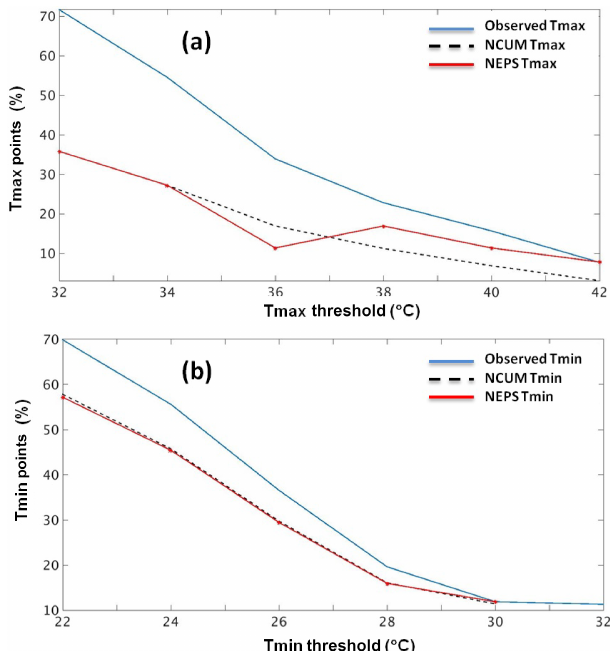
Figure 1. Frequency distribution of observed and forecast (NCUM and NEPS) (a) T max ( ◦ C) and (b) T min ( ◦ C) over India during March to May 2016 (NCUM stands for NCMRWF unified model and NEPS stands for NCMRWF ensemble prediction system; ob- served data from India Meteorological Department and forecast data from NCMRWF). Both panels indicate that the forecasts have a lower frequency compared to observations at lower thresholds. At higher temperature thresholds (>40 ◦ C for T max and >28 ◦ C for T min ), there is better